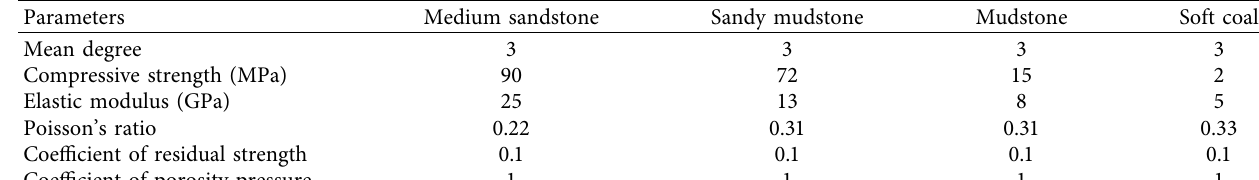
Table 1: Mechanical parameters of numerical simulation model